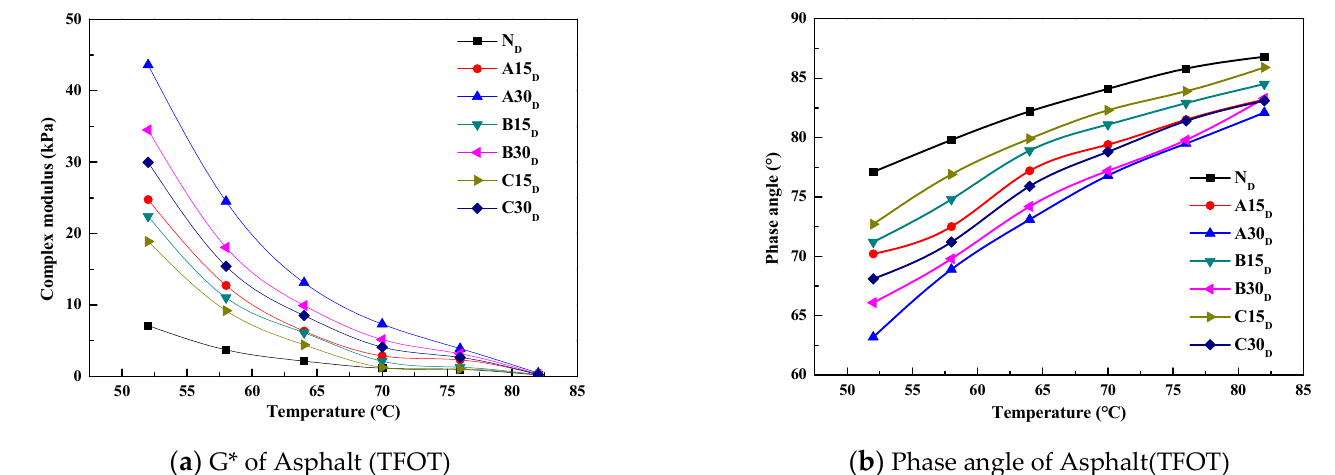
Figure 2. The results of the complex modulus and phase angle versus temperature for the unaged asphalt.